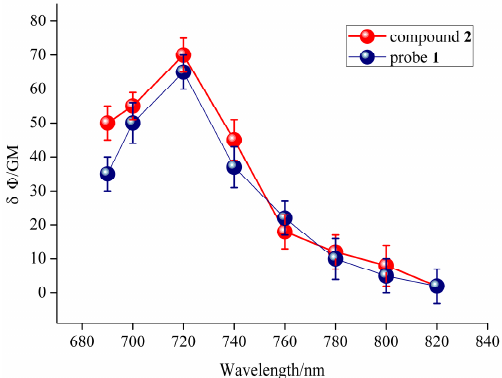
Figure 4. Two-photon action absorption cross-section of probe 1 and compound 2 in CH 3 OH.